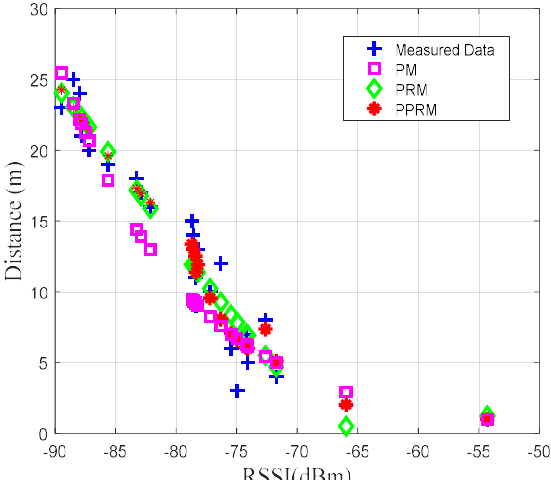
Figure 5. The offline fitting results between received signal strength indicator (RSSI) and distance under three models.